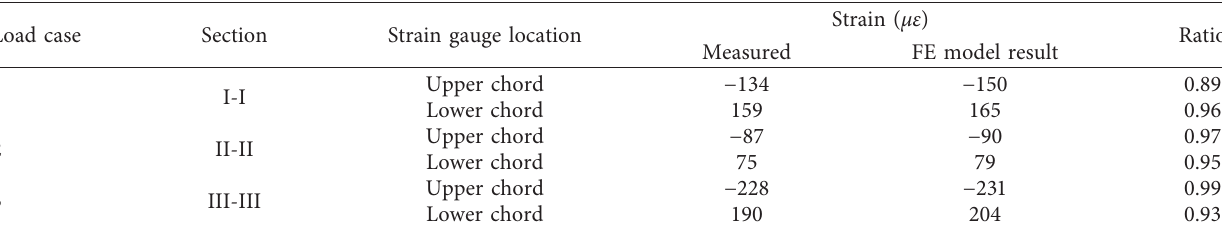
Figure 7: Finite element model of the cable-stayed bridge. Table 2: Strain of the chords for the three load